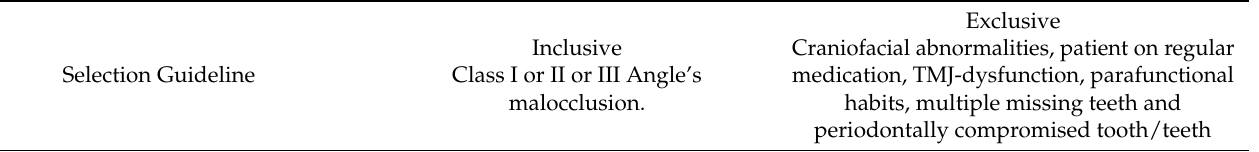
Table 1. Selection guideline, study population and method